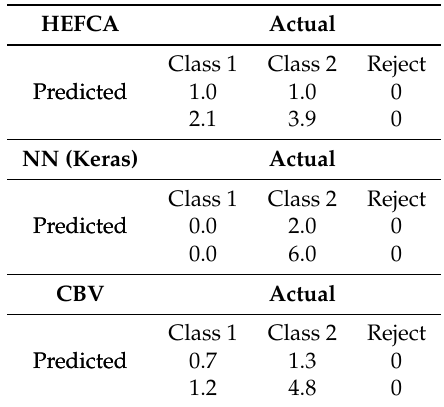
Table 10. Confusion matrixes for the “Listened”